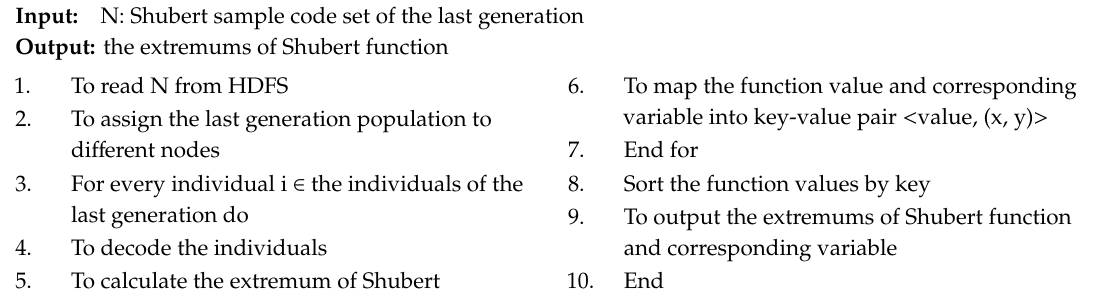
Algorithm 2. Searching